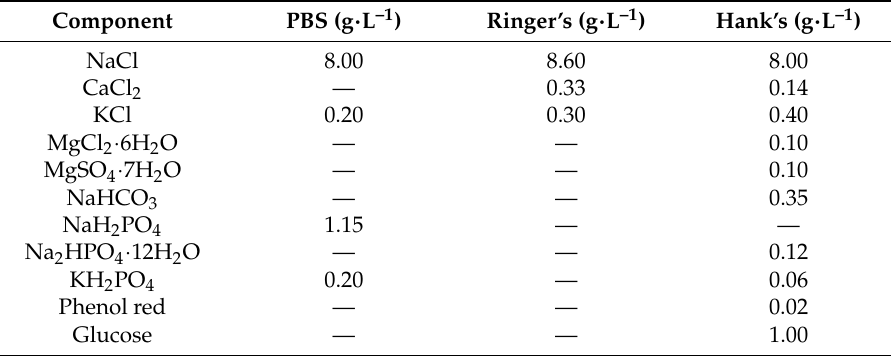
Table 2. Compositions of various simulated body fluids (SBFs)